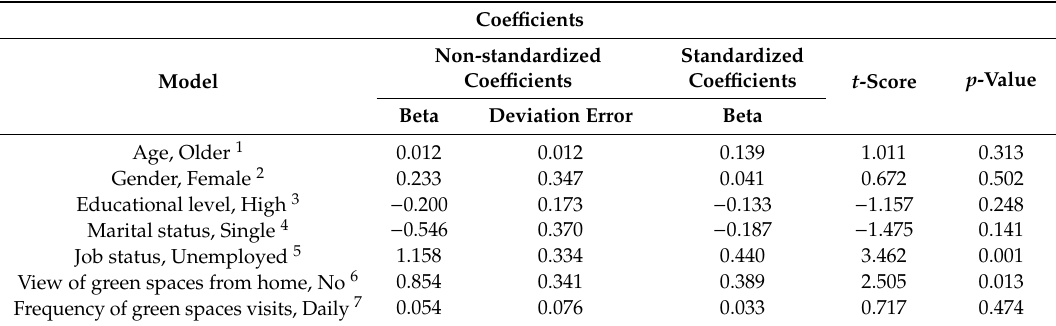
Table 4. Multiple linear regression between depression and sociodemographic variables, view of green spaces from home, and frequency of green space visits in Carmona,